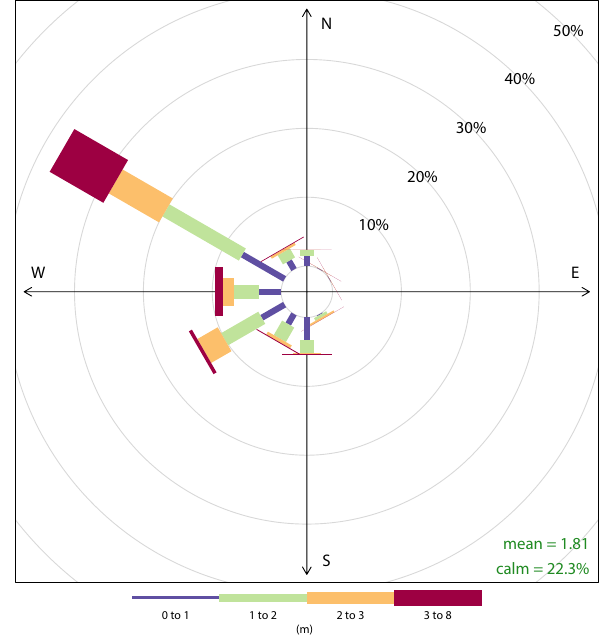
Figure 5. Simulated wave climate over 10 months of hourly time series at